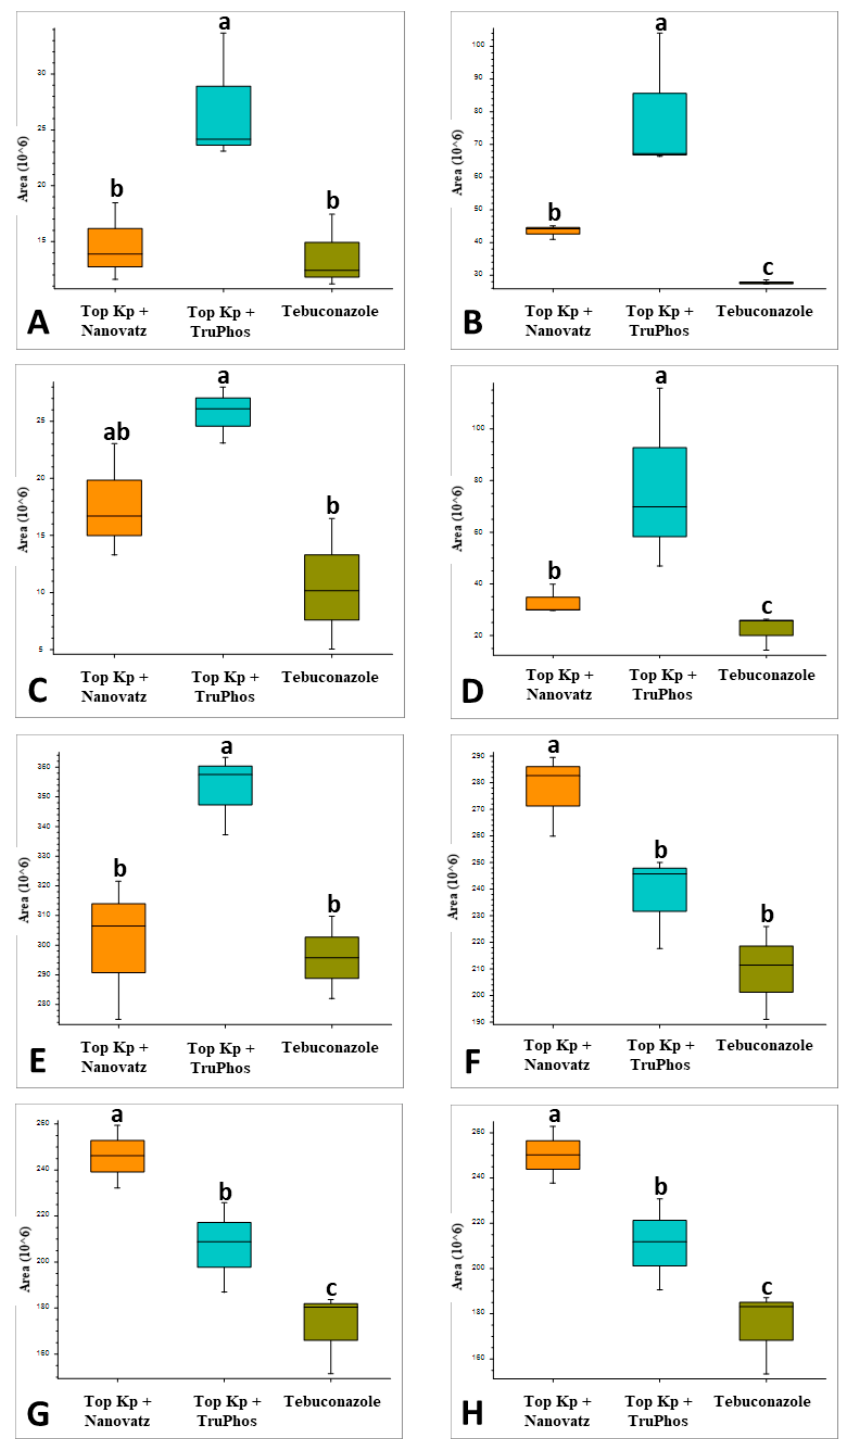
Figure 5. Relative amounts (peak area) of metabolites detected in grape skins of cv. Riesling vines treated with five foliar spays (starting at April 14 until June 3) of the fungicide Folicur (tebuconazole) 0.02%, Top KP+ 1% plus Nanovatz 0.1%, or Top KP+ 1% plus TruPhos 0.25%. Analysis was conducted using LC–MS/MS. ( A ) THP( A ), ( B ) N~2~-(4-Aminobenzoyl) arginine, ( C ) L-Homoarginine, ( D ) 2-Deoxy-2-(methacryloylamino)-D-glucopyranose, ( E ) 6-O-Acetyl-D-glucose, ( F ) L-2-Hydroxyglutaric acid, ( G ) (2S)-2-(beta-D-Glucopyranosyloxy) succinic acid, ( H ) 4-O-Acetyl-D-galacturonic acid. Different letters represent significant differences ( p < 0.05, Tukey-Kramer HSD test).